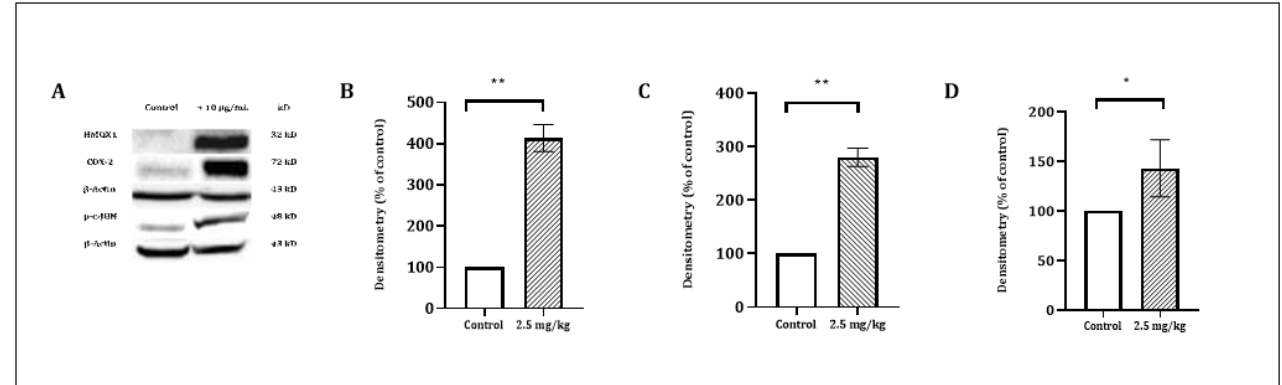
Figure 5. The effect of CSE on the level of COX-2 (72 kD), JUN (48 kD) and HMOX1 (32 kD) proteins. PL45 cells were treated with 10 µ g/mL for 4 h. Proteins were extracted and detected by a Western blot analysis, as described under “Materials and Methods”. ( A ) Representative results. ( B ) Quantitative analysis of COX-2 72 kD, ( C ) JUN 48 kD and ( D ) HMOX1 32 kD using Quantity One software. Density values were calculated as a control from the proper β -actin and as a percent of the control. Statistical significance was determined by the Student’s t -test (* p < 0.01 and ** p < 0.001).